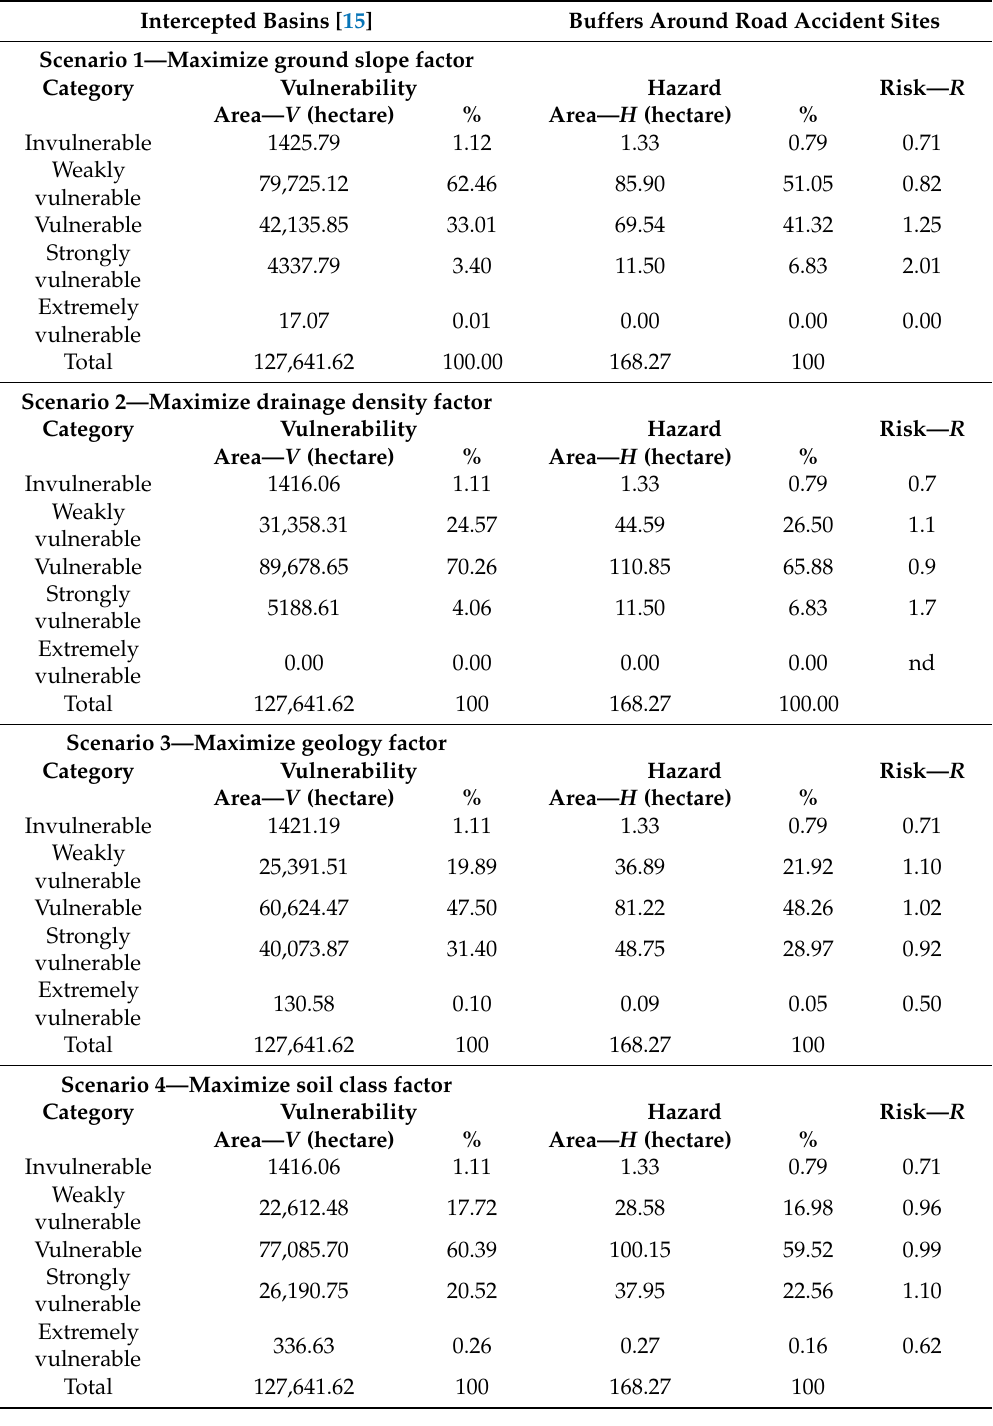
Table 3. Vulnerability assessments within the watersheds that surround the studied segment of BR 050 highway ( V ), considering the four scenarios. Vulnerability assessments within the 200 m buffers that surround the 14 road accidents (also termed hazard assessments; H ), considering the same scenarios. Risk assessments ( R = H/V , in percent